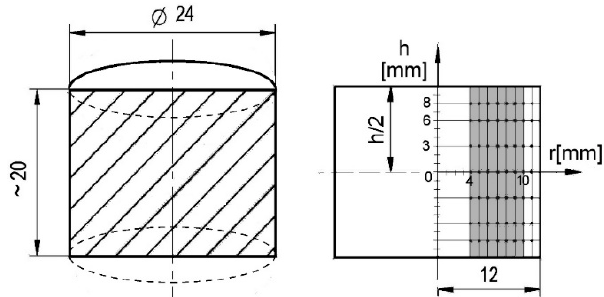
Figure 3. Method of metallographic specimen preparation and the scheme of the measuring grid.